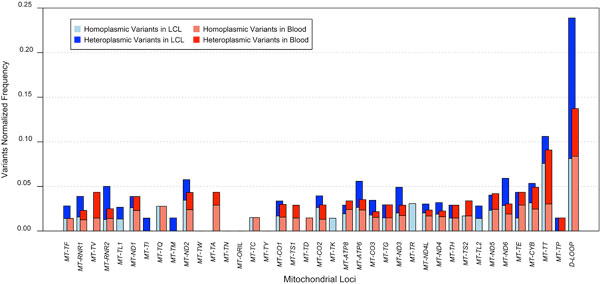
Distribution of homoplasmic and heteroplasmic variants in LCL and blood subsets. Frequencies of homoplasmic and heteroplasmic variants were normalized to the length of mitochondrial loci, in order to eliminate length biases. Variants distribution across mitochondrial loci shows that generally heteroplasmic and homoplasmic mutations occur in the same loci, and this is verified in both datasets. A statistical relevant difference between the distributions of variants within the two datasets was found for heteroplasmic (p < 0.01), but not for homoplasmic variants.